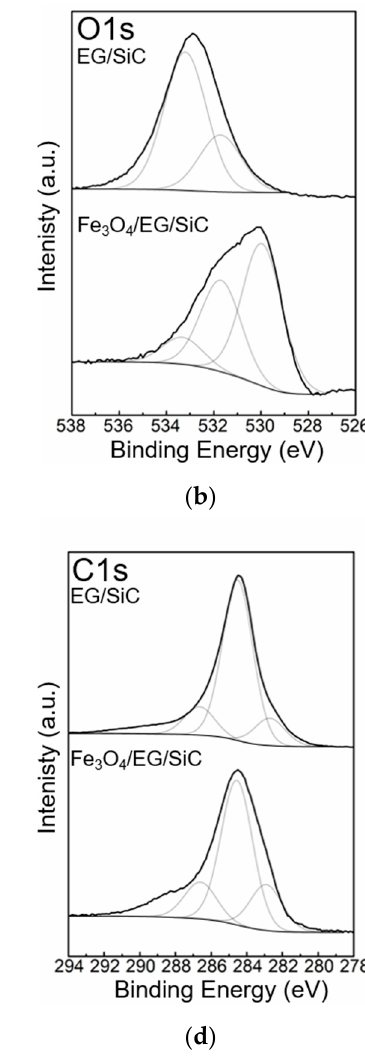
Figure 2. X-ray photoelectron spectroscopy (XPS) survey spectra ( a ), O1s ( b ), Fe2p ( c ) and C1s ( d ) XPS core level spectra for as-grown EG/SiC and Fe 3 O 4 NP deposited on graphene (Fe 3 O 4 /EG/SiC).